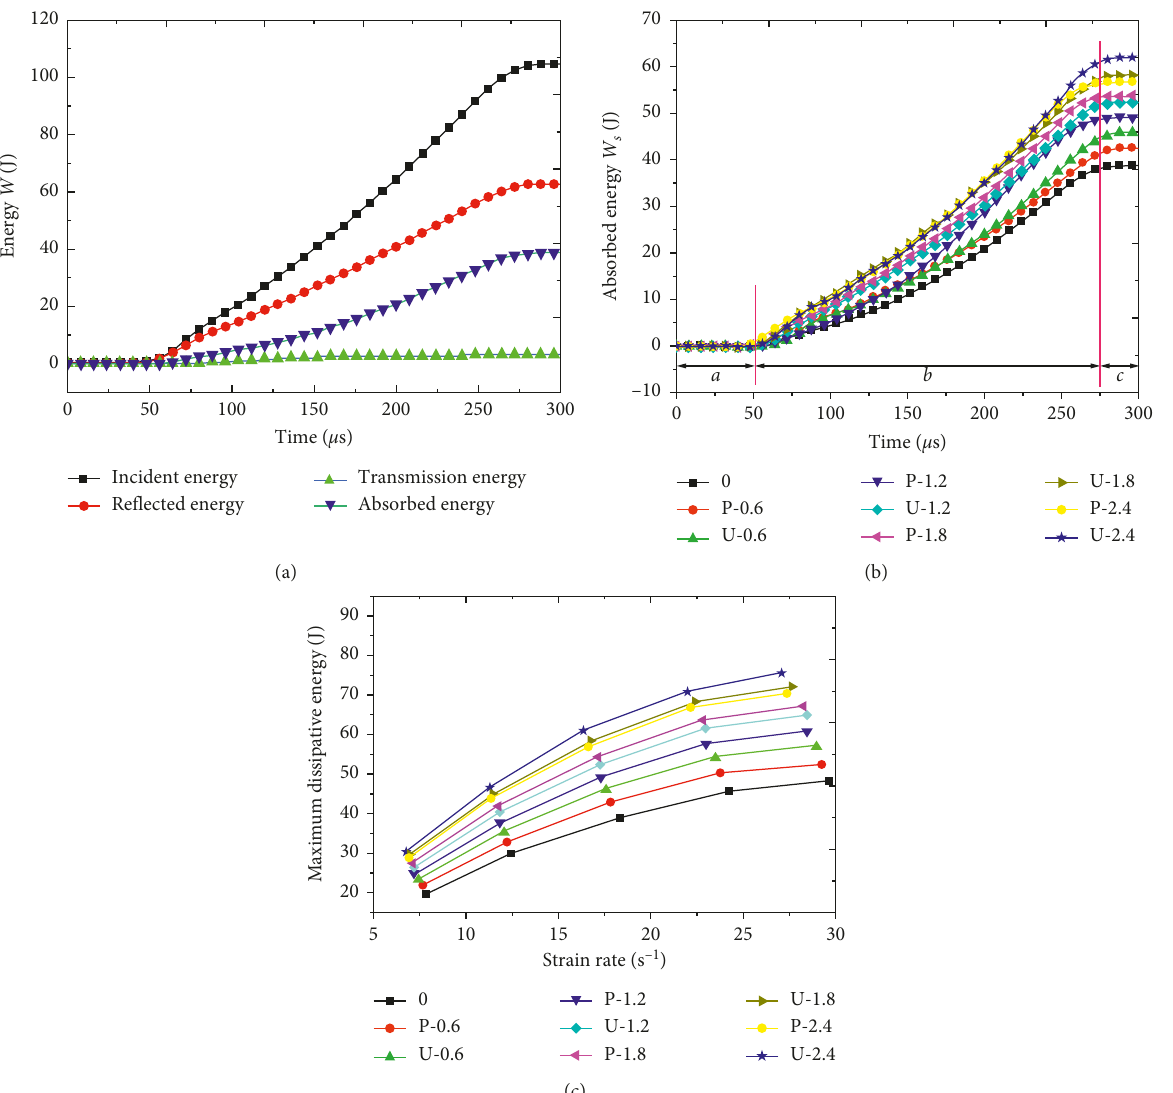
Figure 20: (a) Energy time-history variation in dynamic Brazilian disc test; (b) W relationship between strain rate and maximum dissipation energy of fiber concrete of each